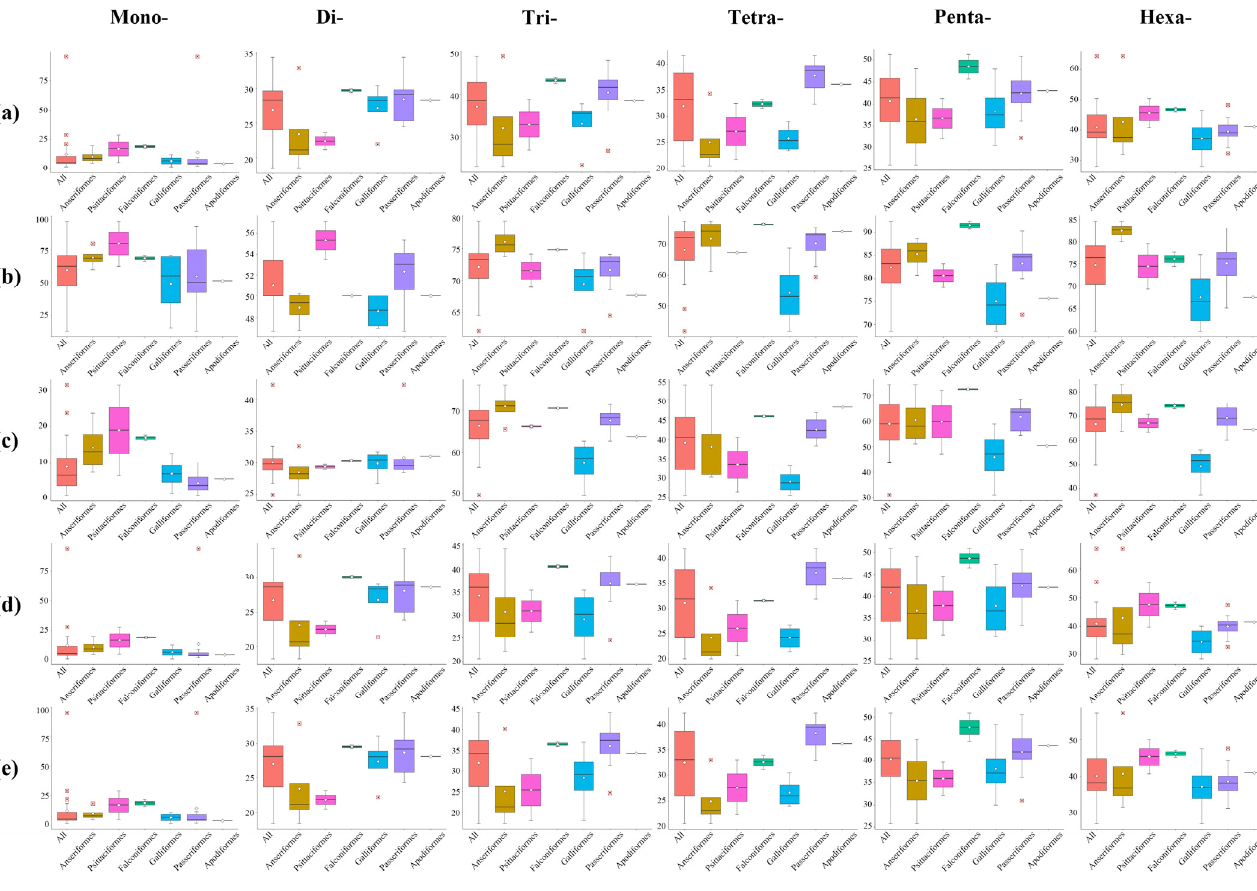
Figure 8. The GC content of P-SSRs in different genomic regions. ( a ) Genome; ( b ) CDS region; ( c ) Exon region; ( d ) Intron region; ( e ) Intergenic region. The small red squares are outliers.